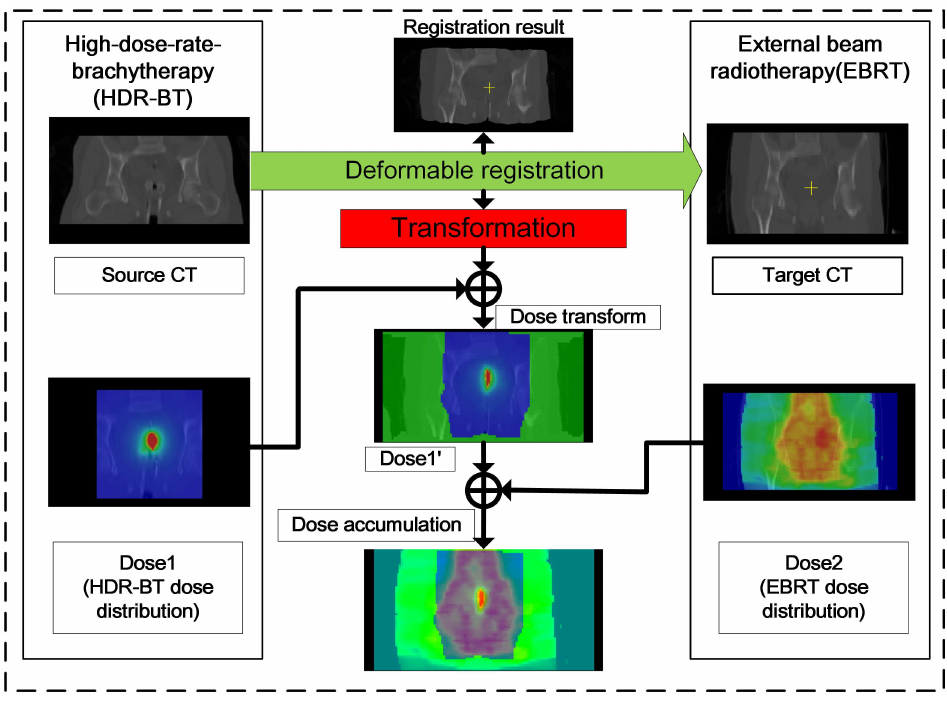
Fig 2. Scheme of dose accumulation between EBRT and